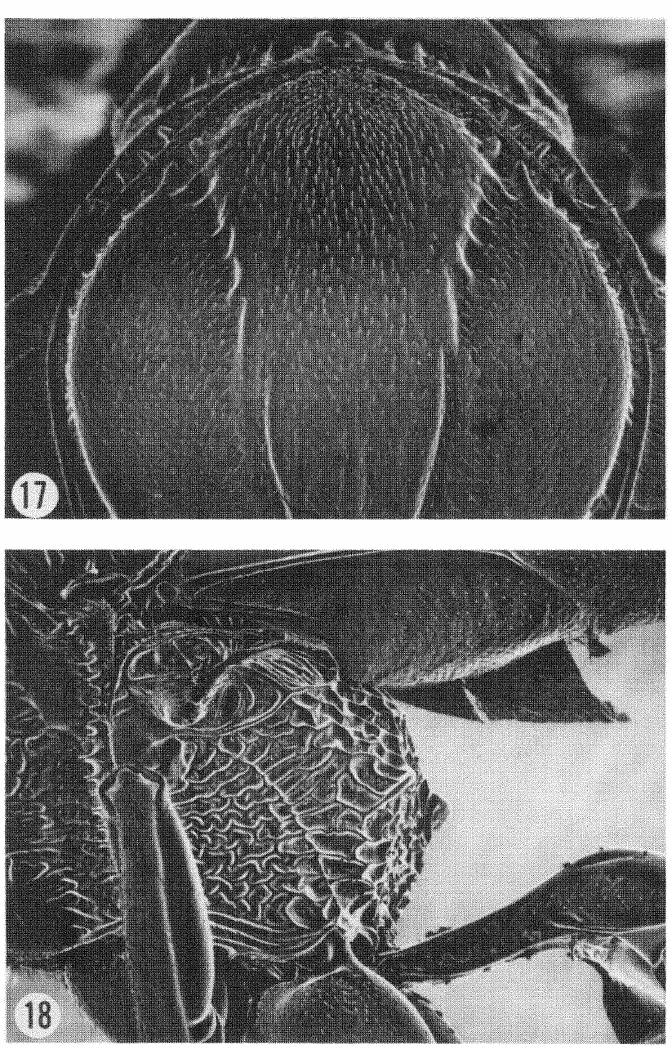
Fig. 17. Cosmiocryptus weyrauchi, tum and most of mesoscutum in dorsal view. Fig. 18. Cosmiocryptus weyrauchi, mesopleuron, propodeum, and most of first gastric tergite in lateral